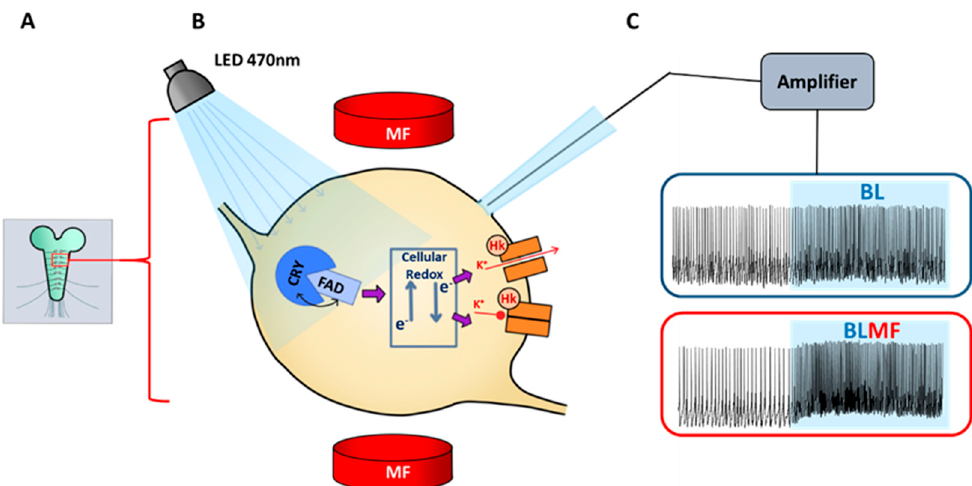
Figure 3. Diagrammatic representation of a patch-clamp electrophysiological recording from a Drosophila larval aCC motoneuron ectopically expressing DmCRY ( A ) An isolated larval central nervous system (CNS) is placed in a recording chamber between two static bar magnets (100 mT) with a patch electrode recording from an aCC motoneuron. ( B ) Cryp- tochrome is sufficient to impart BL sensitivity. The canonical mechanism suggests that illumination with blue light (BL) results in electron transfer between CRY and its cofactor FAD. In this active state, the conformation of CRY is altered, and the C-terminal of the protein, a region known to be important for interactions with other proteins, is exposed. How the activation of CRY signals to the neuron is not understood. However, the redox state of the cell has been shown to be an essential link between CRY activation and the depolarisation of the neuron through the closure of potassium channels, signalled via the intrinsically redox-sensitive Kv β potassium channel subunit HYPERKINETIC (HK) [35]. ( C ) A closure of potassium channels leads to retention of positively charged potassium ions in the cell and a positive change in the membrane potential of the neuron. This can be observed by “patching the neuron” with an electrode. Following BL (light blue box), a rapid increase in both membrane potential and in action potential firing is observed. This effect is potentiated in the presence of a 100 mT magnetic field